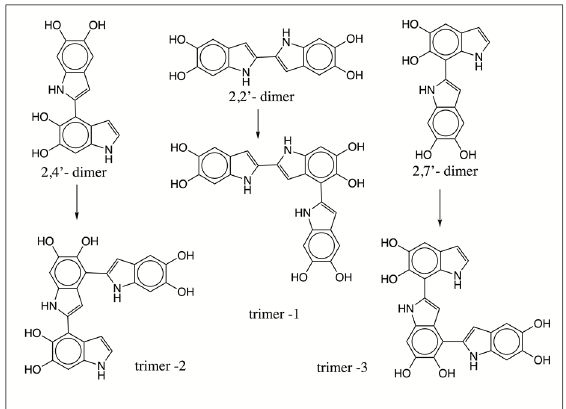
Figure 14. Proposed mechanism for the formation of trimeric products of DHI during nonenzymatic oxidative polymerization of DHI. Different DHI dimeric products generated during the initial stages of oxidation (shown in Figure 13) will undergo further condensation with the oxidized form of DHI, yielding trimeric products of DHI. Only one possible structure of the trimeric product arising from each of the dimeric species is illustrated. However, many other isomeric forms are possible. Interestingly, all of the isomeric compounds will exhibit a similar CID spectrum, losing a DHI unit, as shown in Figure 7.